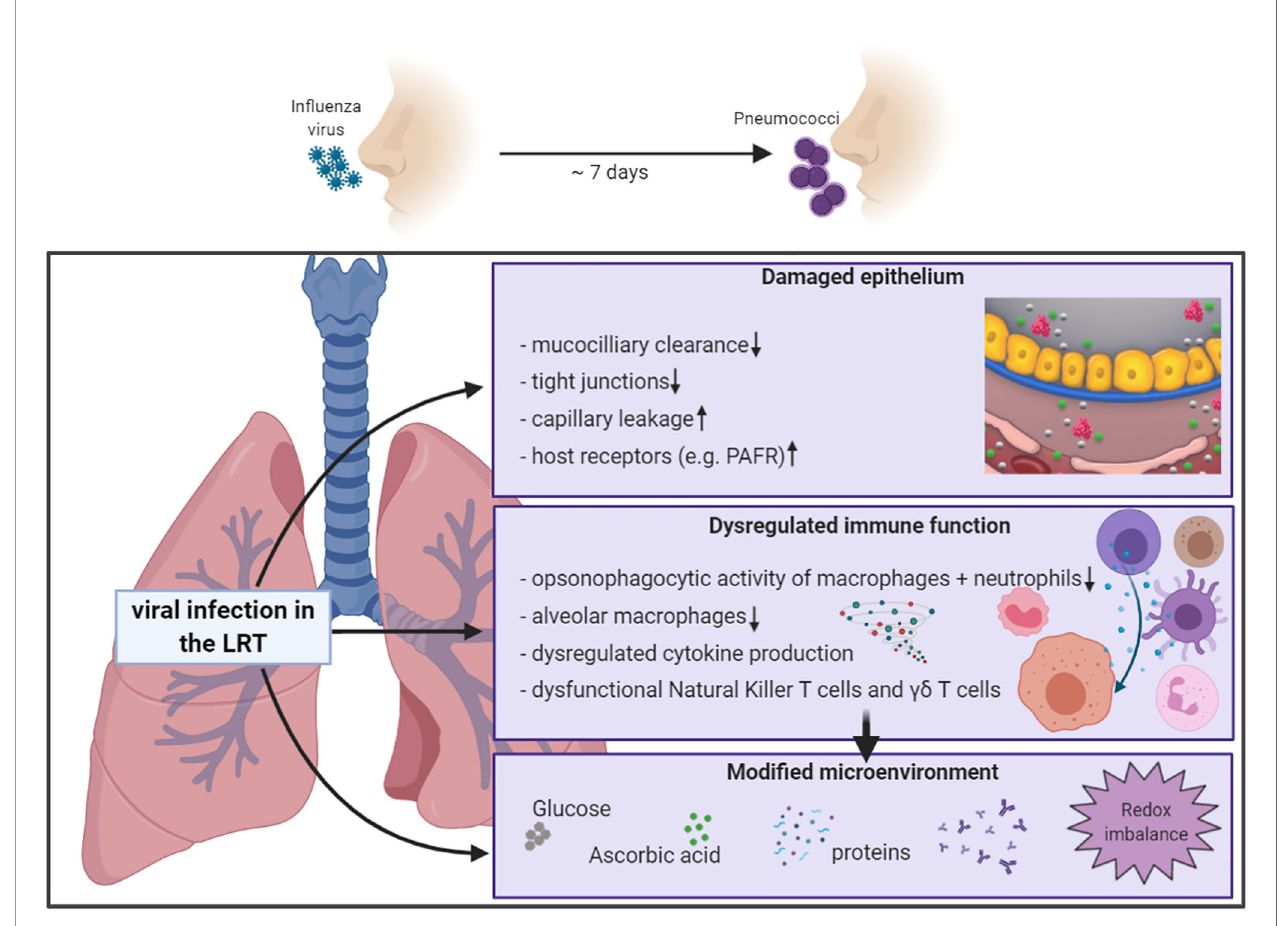
FIGURE 1 | Schematic overview of in fl uenza-induced alterations of the pulmonary host response. Increased sensitivity to secondary bacterial infection is partly mediated by in fl uenza-induced effects on the pulmonary host response, including compromised epithelial barrier functions, innate and adaptive immune responses, and changes of the microenvironment in the respiratory tract. Partly adopted from Sender et al., 2020. Created with BioRender.com